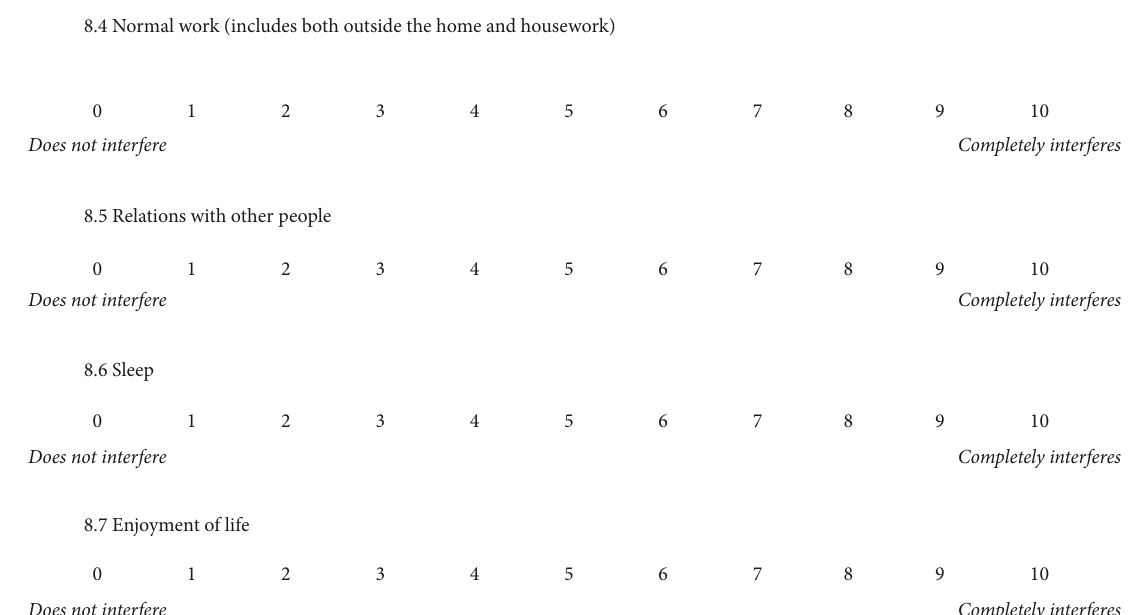
Figure 5: English version of the